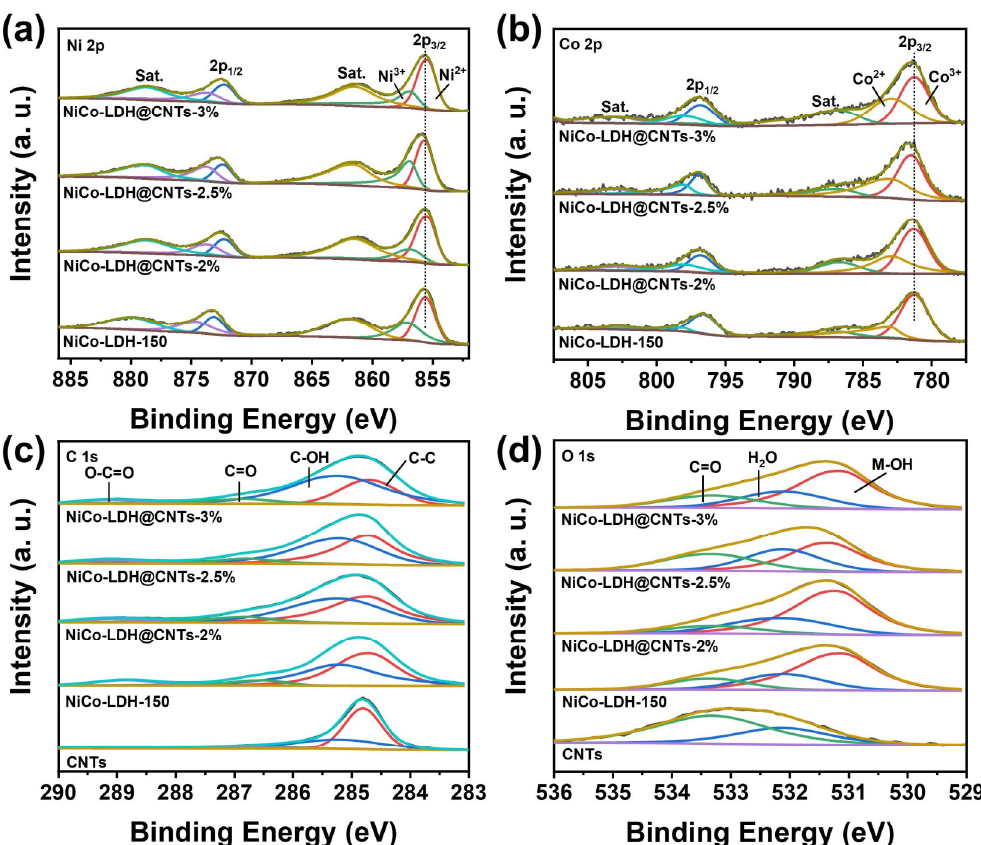
Figure 3. ( a ) Ni 2p and ( b ) Co 2p XPS spectra of NiCo-LDH-150 and NiCo-LDH@CNTs- z % ( z = 2, 2.5, and 3). ( c ) C 1s and ( d ) O 1s XPS spectra of CNTs, NiCo-LDH-150, and NiCo-LDH@CNTs- z % ( z = 2, 2.5, and 3).